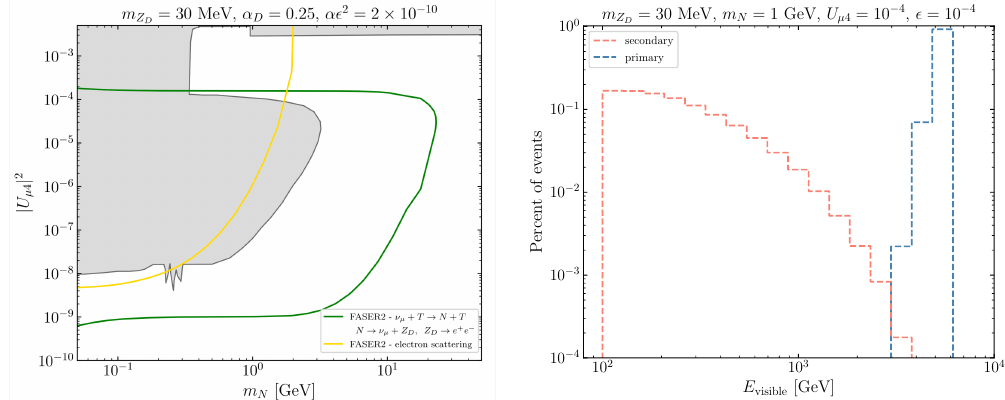
Figure 3 . Left : the sensitivity reach of FASER 2 in the model with the dark gauge boson mediator between the HNLs and SM particles. We vary the mass and the mixing angle of the HNL, while other parameters of the model are fixed, as shown in the plot. The gray-shaded region corresponds to the currently excluded region in the parameter space of the model (see the text for details). νZ → Z ( N → νZ D ) with the subsequent decay Z D → e + e − , is shown with the green solid line. ATLAS IP. This is not shown in the plot, as it does not depend on the mixing angle and mass of the HNL. The yellow solid line corresponds to the expected sensitivity reach of FASER ν 2 based on the electron scattering signature. Right : the energy spectrum of e + e − pairs from Z decays. D The blue histogram corresponds to the primary production of Z s at the ATLAS IP, while the D orange one is relevant for the secondary production of the dark gauge boson as a result of the neutrino upscattering in front of the detector. The parameters of the model chosen to prepare both histograms are indicated in the